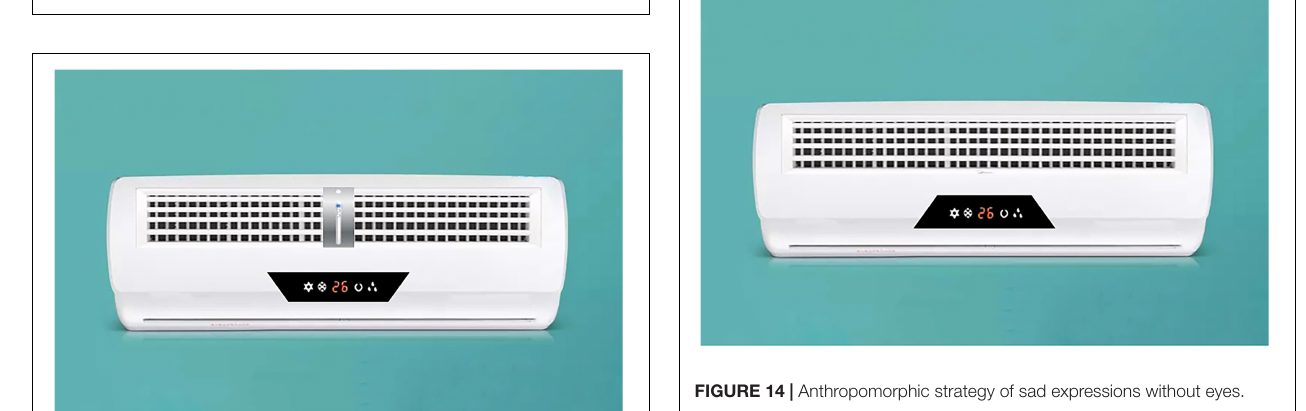
FIGURE 10 | Moderating role of expression.